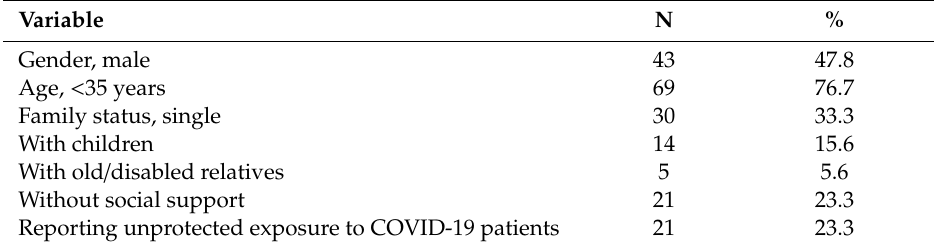
Table 1. Characteristics of the